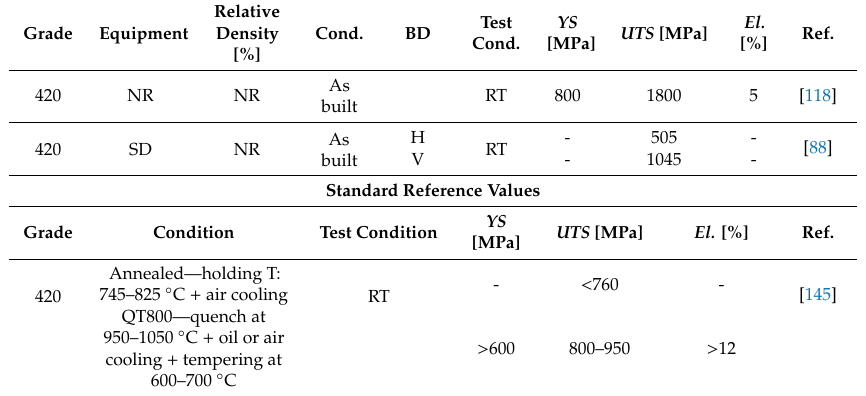
Table5. Tensilestrengthofmartensitic420alloyobtainedfromL-PBF,comparedtostandardreferencevalues.